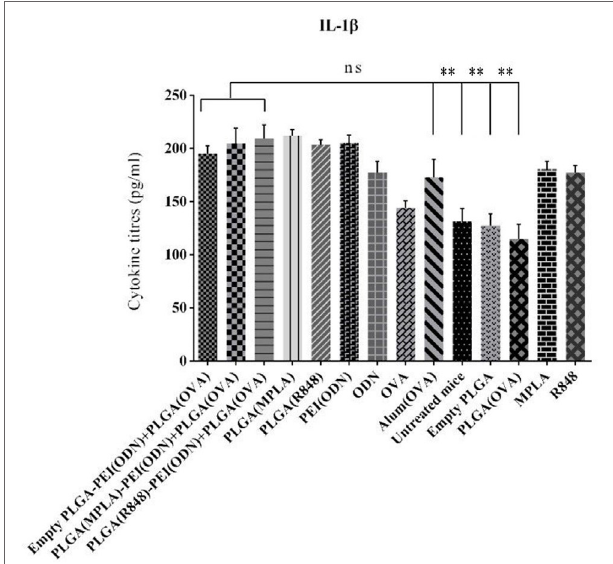
FigUre 10 | Detection of IL-1 β level in the serum in BALB/c mice immunized with various toll-like receptor (TLR) agonists adjuvant formulations along with poly(lactic-co-glycolic) acid (PLGA) [ovalbumin (OVA)] NPs. Serum IL-1 β level was determined using enzyme-linked immunosorbent assay. There was no significant difference in IL-1 β secretion between different adjuvant formulations in comparison with positive control (OVA + aluminum hydroxide). The asterisks located on top of the lines showed comparison of significance between the main (dual TLRs agonist) and naive (untreated mice) as well as mice immunized with empty PLGA and PLGA (OVA). The data are indicated the mean ± SD ( n = 3).